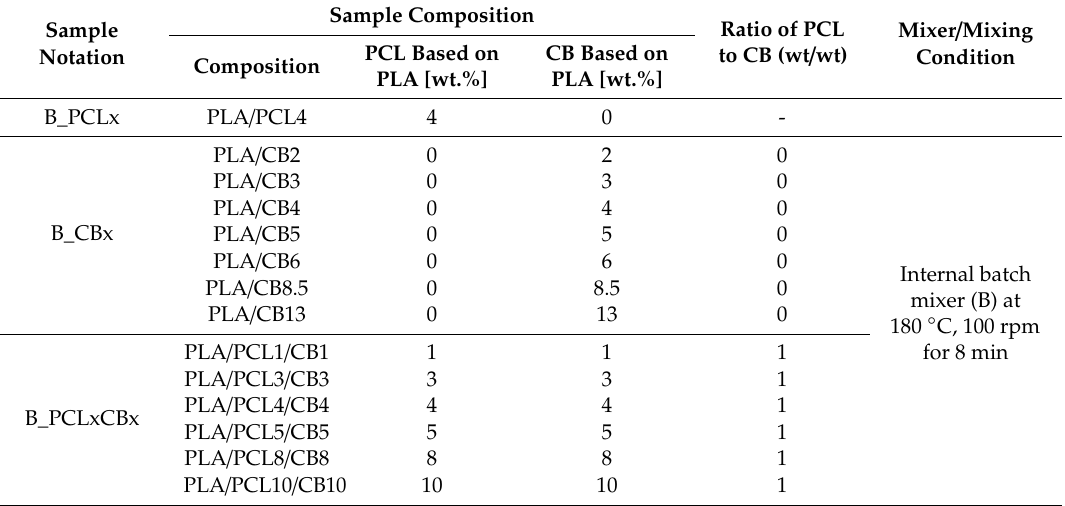
Table 1. Composition and notation of the binary poly(lactic acid) / carbon black (PLA / CB) and ternary PLA / PCL (poly(caprolactone)) / CB composites.